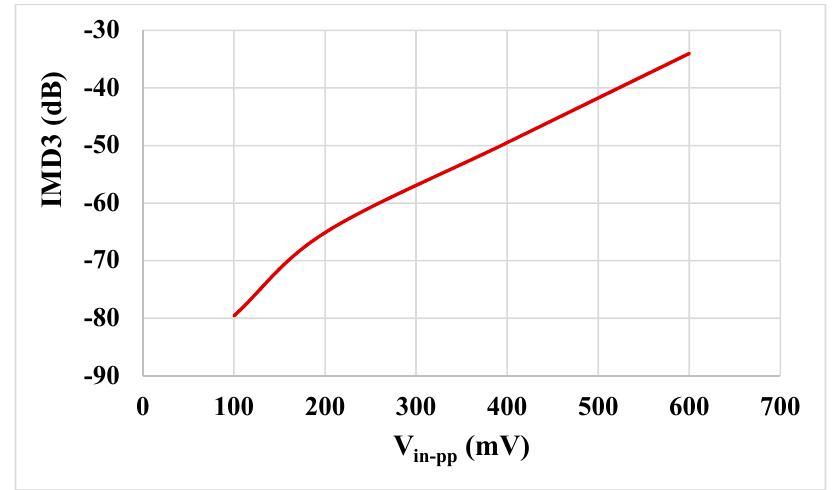
Figure 16. The spectrum of the output signal of the BP filter.